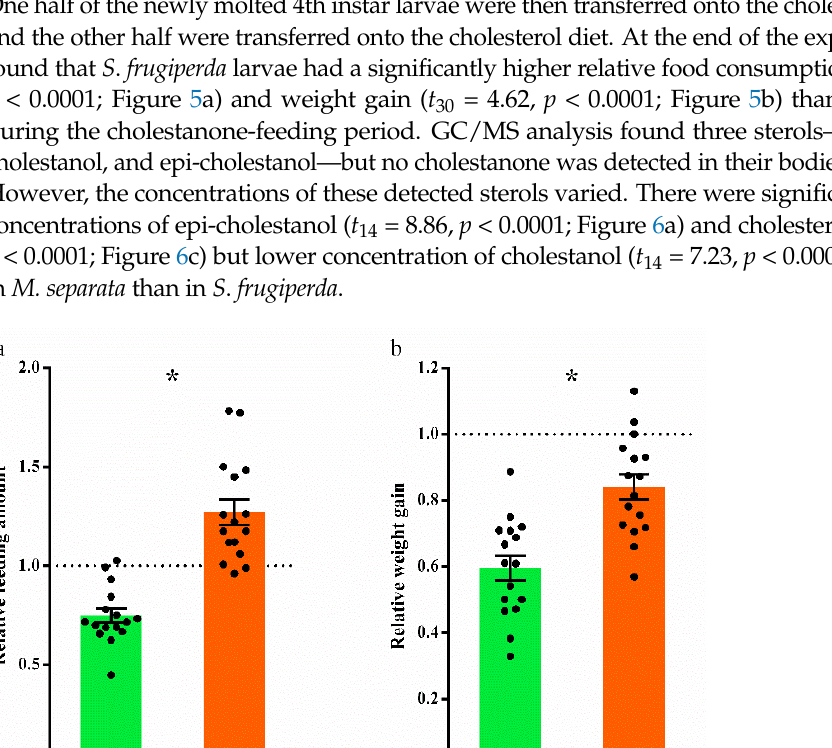
Table 1. Performance of the two caterpillars reared on a diet containing cholesterol, cholestanol, or cholestanone at a concentration of 1 mg/g (dry mass). * in each row indicates significant differences compared to the cholesterol treatment at p < 0.05.